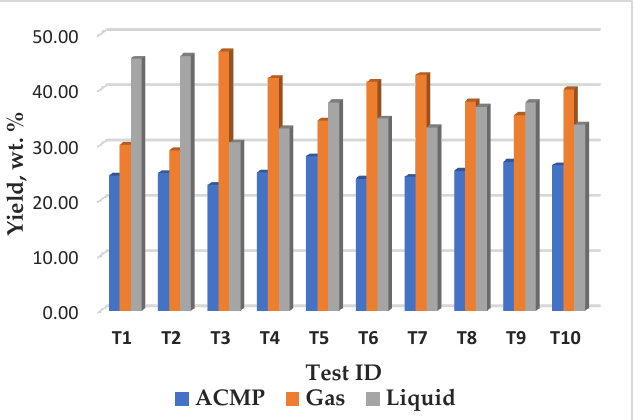
Figure 7. The yield of the reaction products obtained during the synthesis of ACMP in the microwave field.